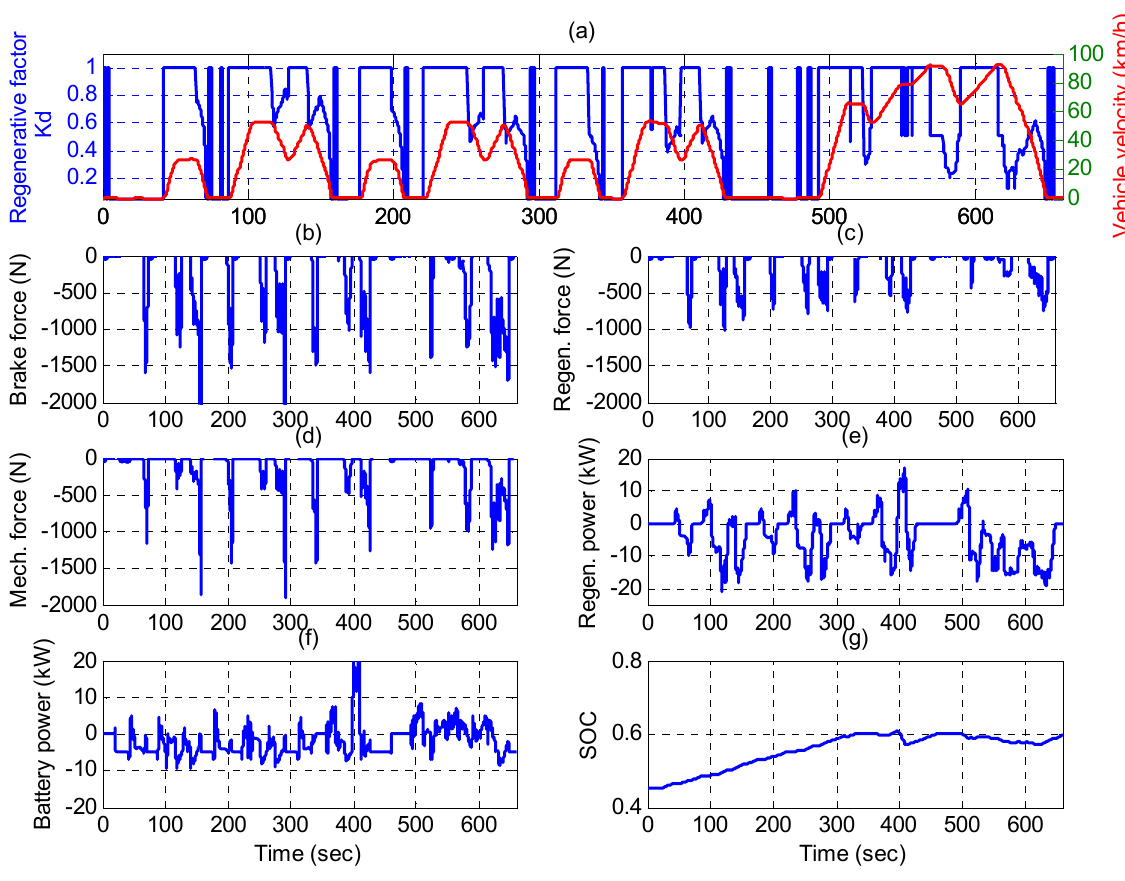
Figure 13. Simulation results of the FL regenerative braking controller for the PM-EVT-HEV during a Modified Prius1015: ( a ) Modified Prius1015 and the regenerative factor; ( b ) Total braking force; ( c ) Regenerative force by EM2; ( d ) Mechanical